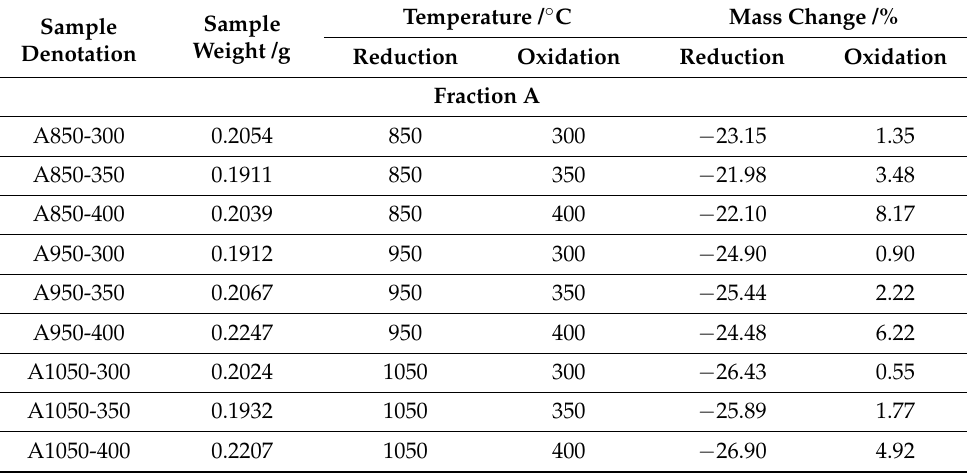
Figure 6. TG/DTA curves recorded during the thermal analysis of mill scale from metallurgical process (fraction A) subjected to reduction (carbon monoxide) at 850 °C, 950 °C, and 1050 °C, followed by exposure to an oxidizing atmosphere (synthetic air) at temperatures of 300 °C, 350 °C, and 400 °C. Table 3. Denotations and mass change of mill scale fractions A and B during thermal